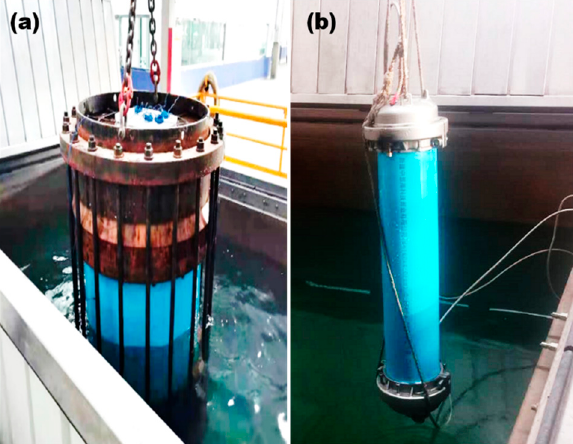
Figure 10. Equipment of burst pressure test ( a ) P1200-1 and ( b ) P160-1.